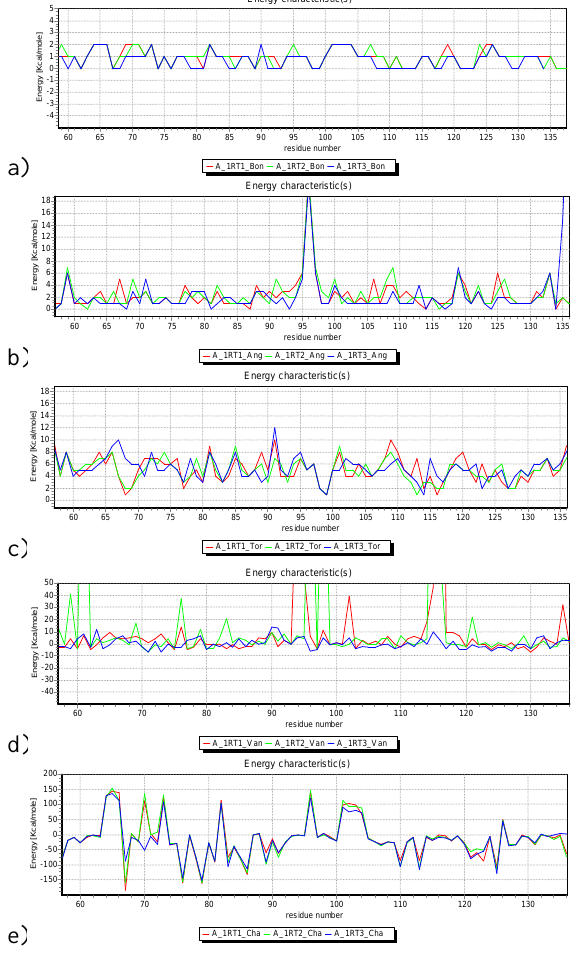
Fig. 5. Different energy characteristics: a) bond stretching, b) angle bending, c) torsional angle, d) van der Waals, e) electrostatic, for three molecules of the HIV-1 DNA transcriptase (PDB ID: 1RT1, HIV-1 Reverse Transcriptase Complexed with MKC-442, PDB ID: 1RT2, HIV-1 Reverse Transcriptase Complexed with TNK-651, and PDB ID: 1RT3, AZT Drug Resistant HIV-1 Reverse Transcriptase Complexed with